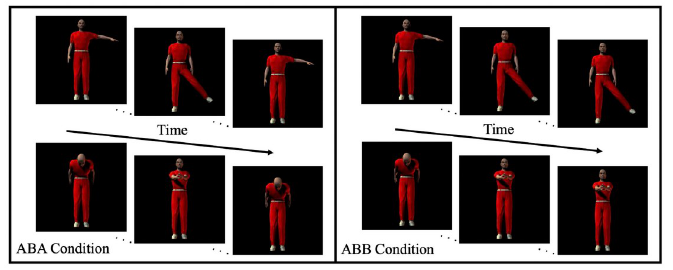
Fig 2. Examples of habituation materials from the ABA and ABB conditions in Experiment